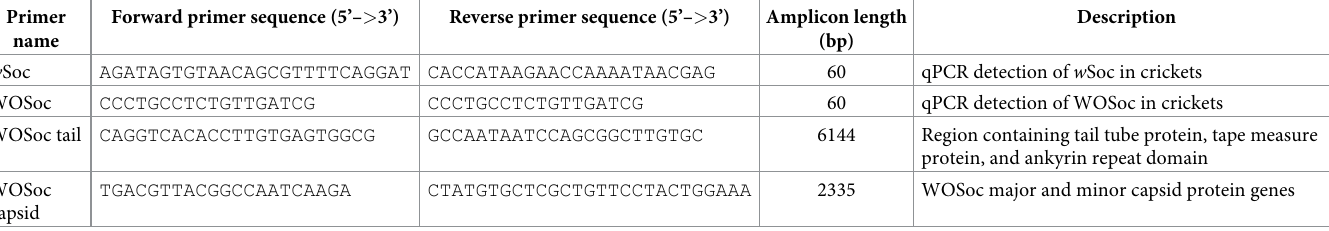
Table 1. List of primers designed and used in the